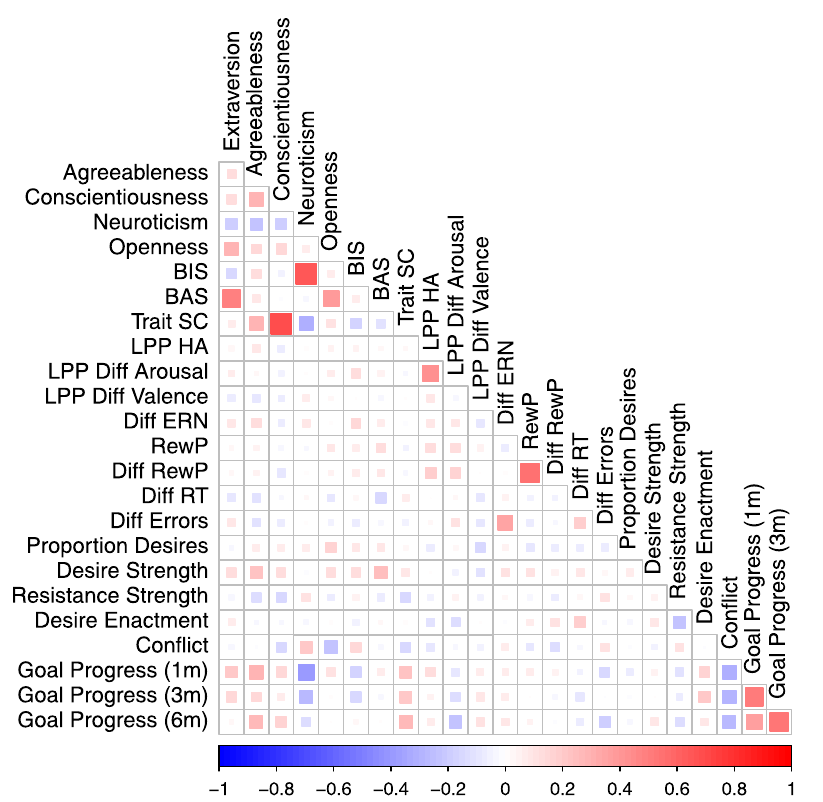
Fig. 5 Pearson ’ s correlation plots showing associations among dependent variables in our study. Increasing size and saturation of squares depict the effect size, negative correlations are shown in blue and positive correlations in red. BIS: Behavioral Inhibition System; BAS: Behavioral Activation System; Trait SC: Trait Self-Control Scale; LPP HA: LPP to high arousal positive images; LPP Diff Arousal: LPP difference score (high arousal − low arousal); LPP Diff Valence: LPP difference score (positive valence − negative valence); Diff ERN: ERN difference score (error − correct); RewP: Reward Positivity; Diff Rew P: RewP difference score (correct − error); Diff RT: reaction time difference on the fl anker task (incompatible – compatible); Diff Errors: error rate difference on the fl anker task (incompatible –